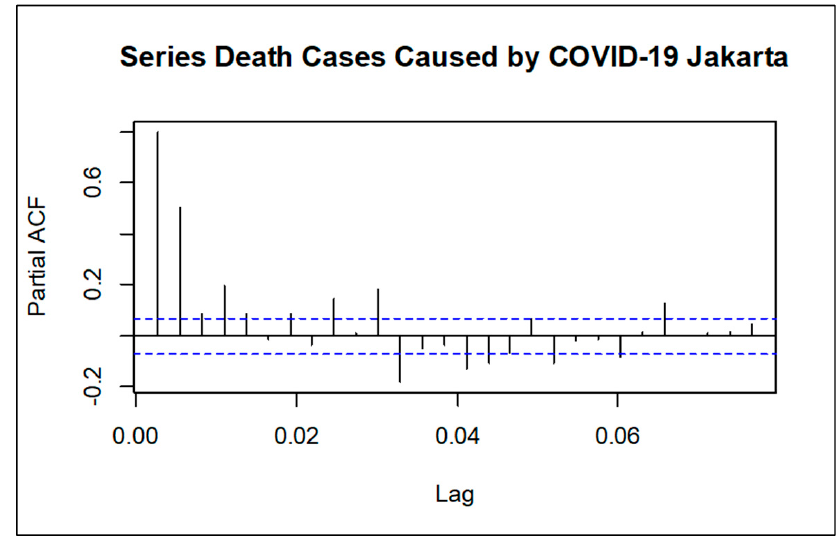
Figure 5. PACF plot for death cases caused by COVID-19 in Jakarta.